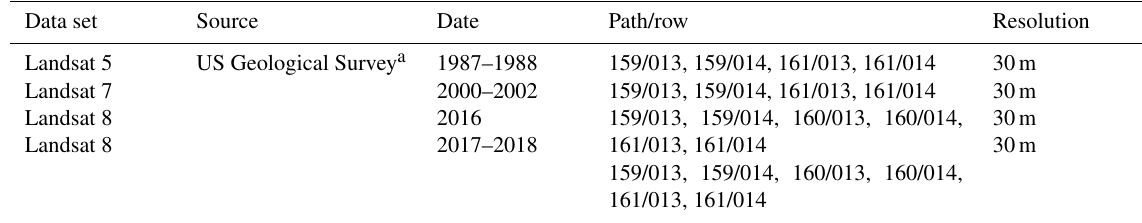
Table 3. Data sets used for fire analysis. Data set